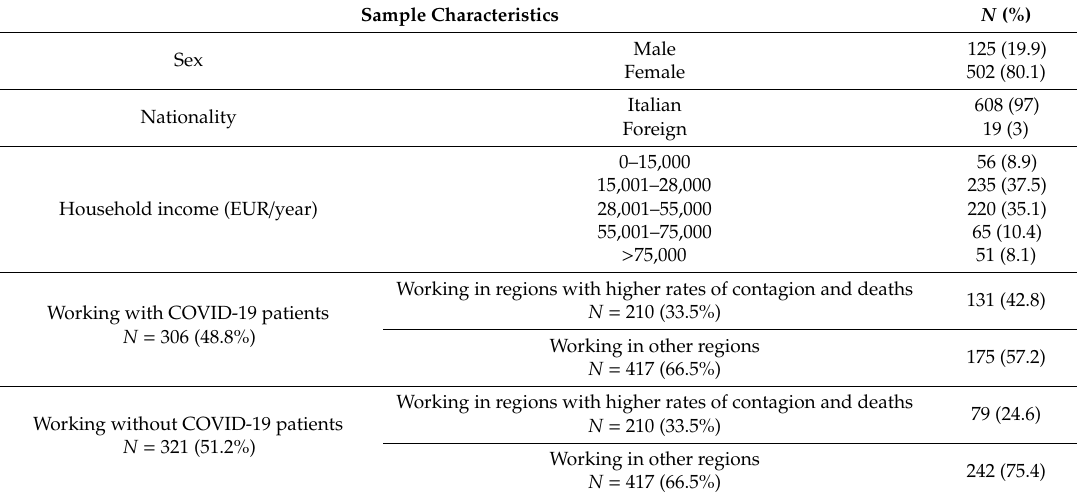
Table 1. Demographic characteristics of the study sample ( N =